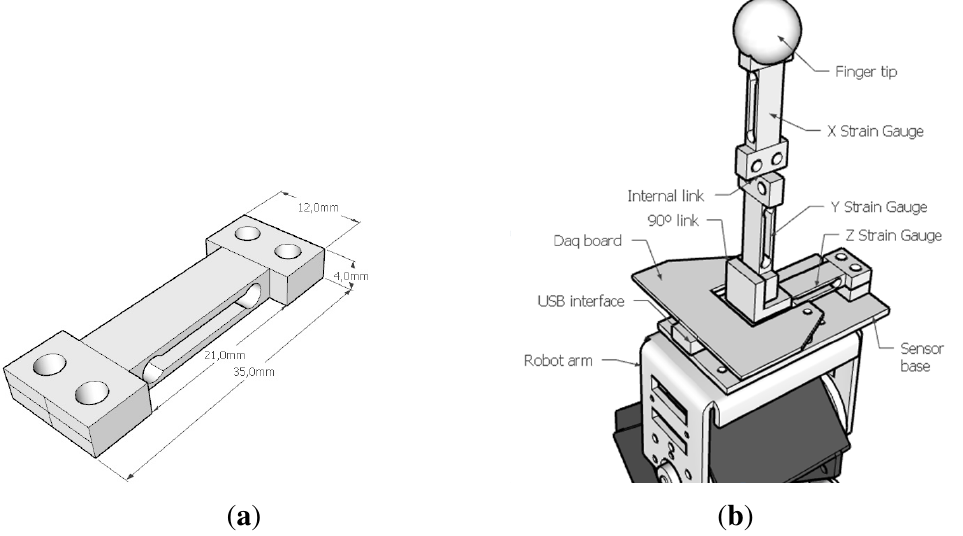
Figure 6. The physical force sensor has been built using three load cells and a specialized data acquisition board. ( a ) Micro-load cell dimensions; ( b ) three-axis force sensor